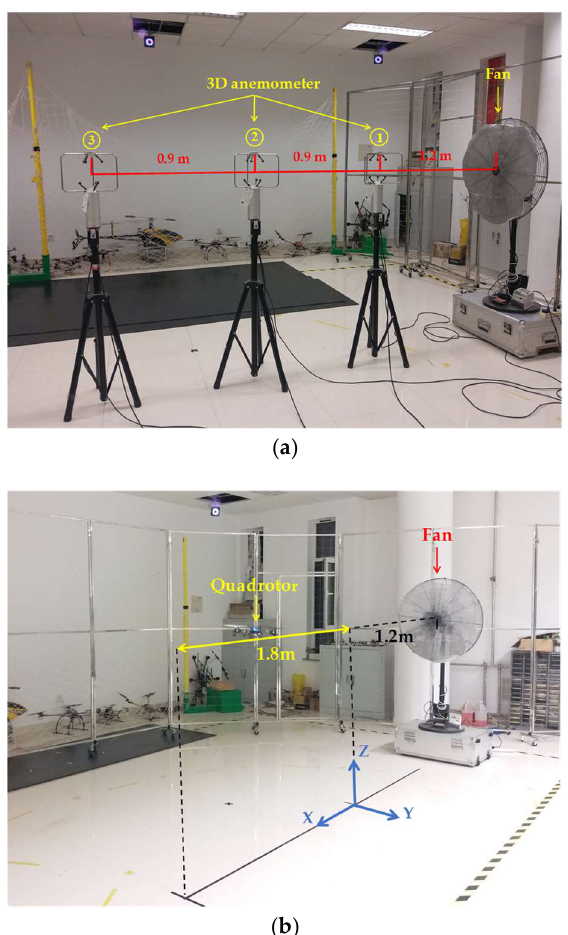
Figure 13. Scenes of the verification experiment. ( a ) Wind measurement by three 3D anemometers. ( b ) Wind estimation with a quadrotor.